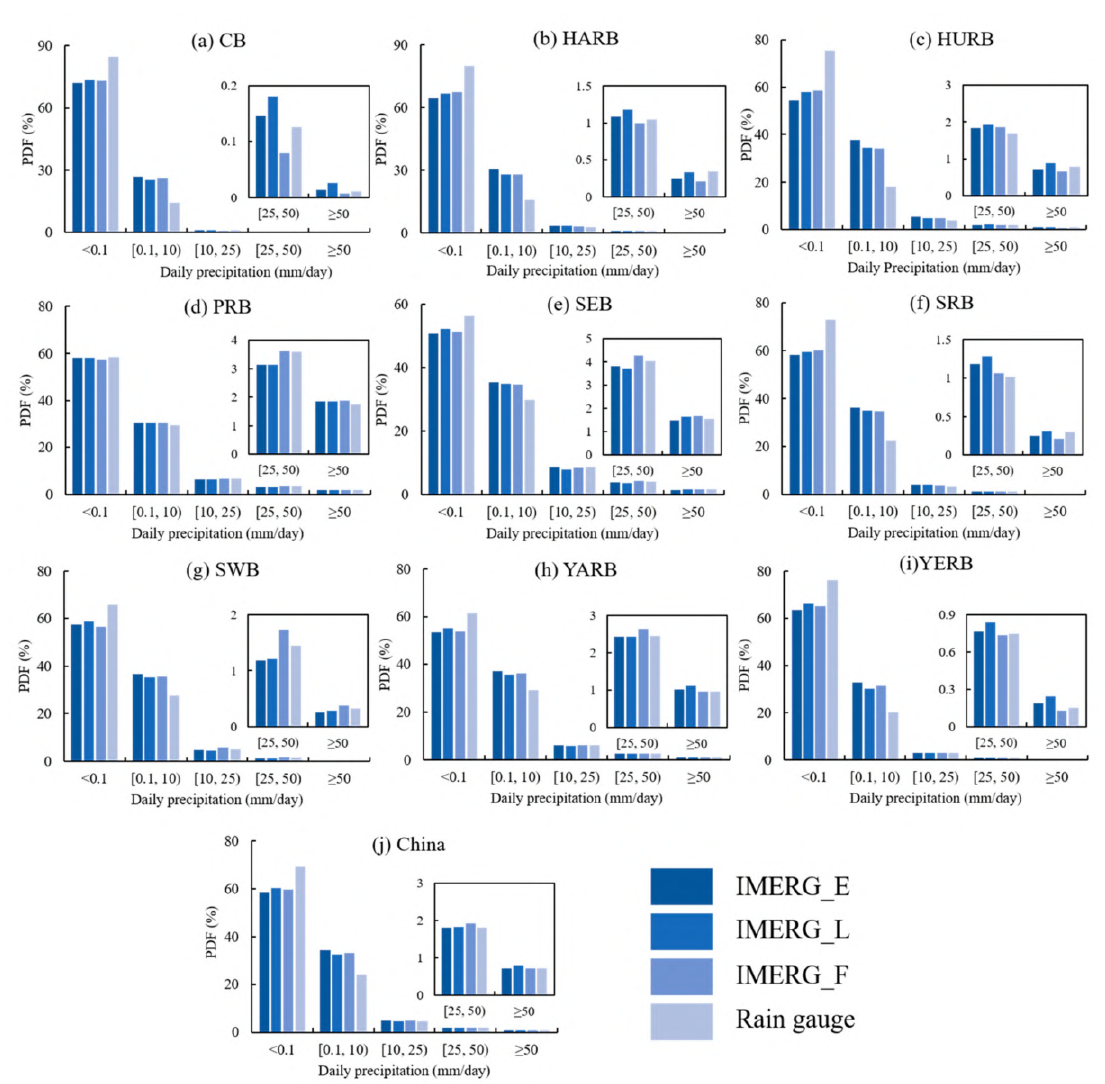
Figure 8. Probability distribution function (PDF) of IMERG_E, IMERG_L and IMERG_F products and rain gauge in different precipitation intensity classes across nine basins ( a – i ) (CB, Continental Basin; HARB, Haihe River Basin; HURB, Huaihe River Basin; PRB, Pearl River Basin; SEB, Southwest Basin; SRB, Songliao River Basin; SWB, Southwest Basin; YARB, Yangtze River Basin; YERB, Yellow River Basin) and China ( j ) during 2008 to 2017. Table 5. Performance metrics associated with IMERG products in four precipitation bins on a daily scale across China. Precipitation Bin (mm/day)